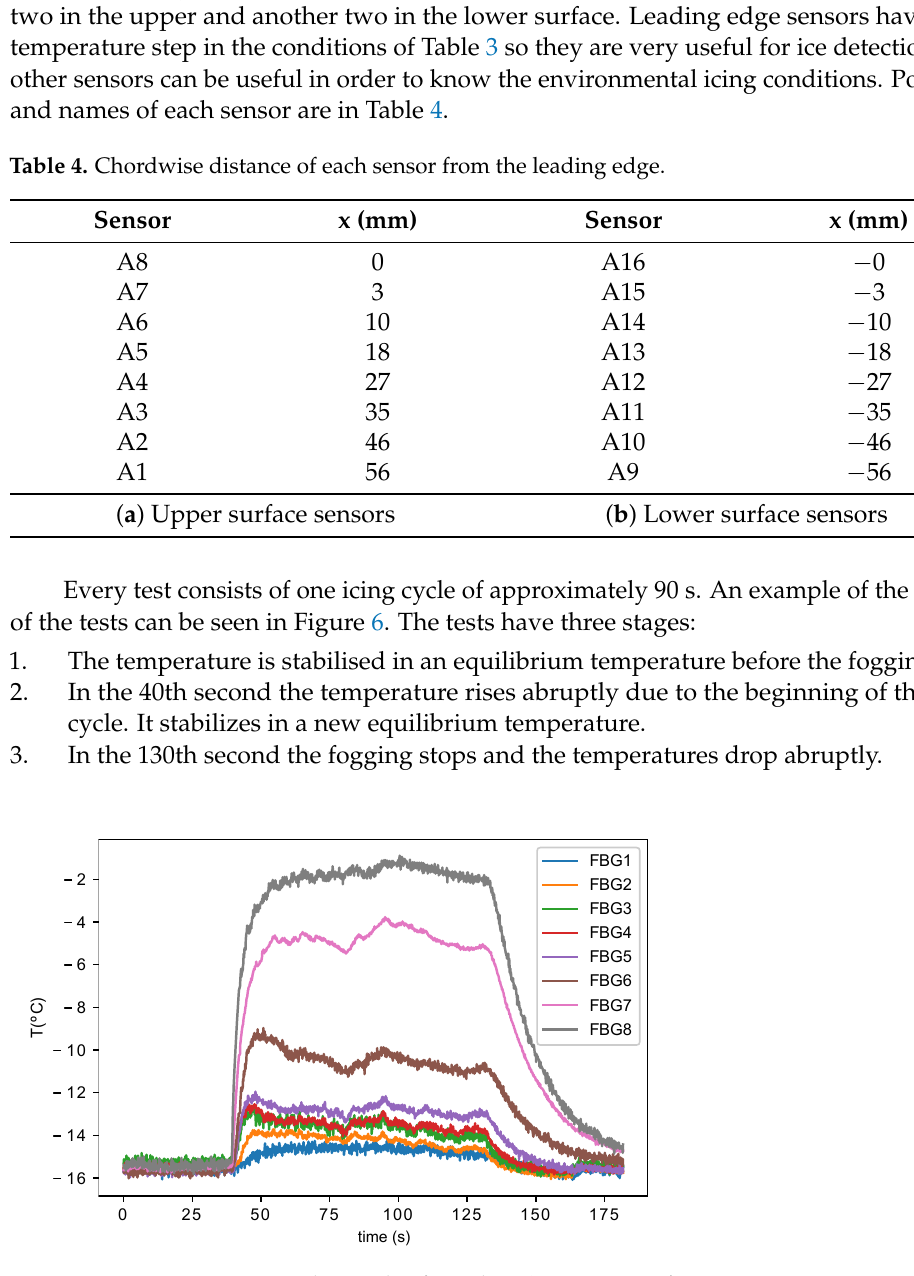
Figure 6. Test structure example. Angle of attack: 10 ◦ . V TS = 70